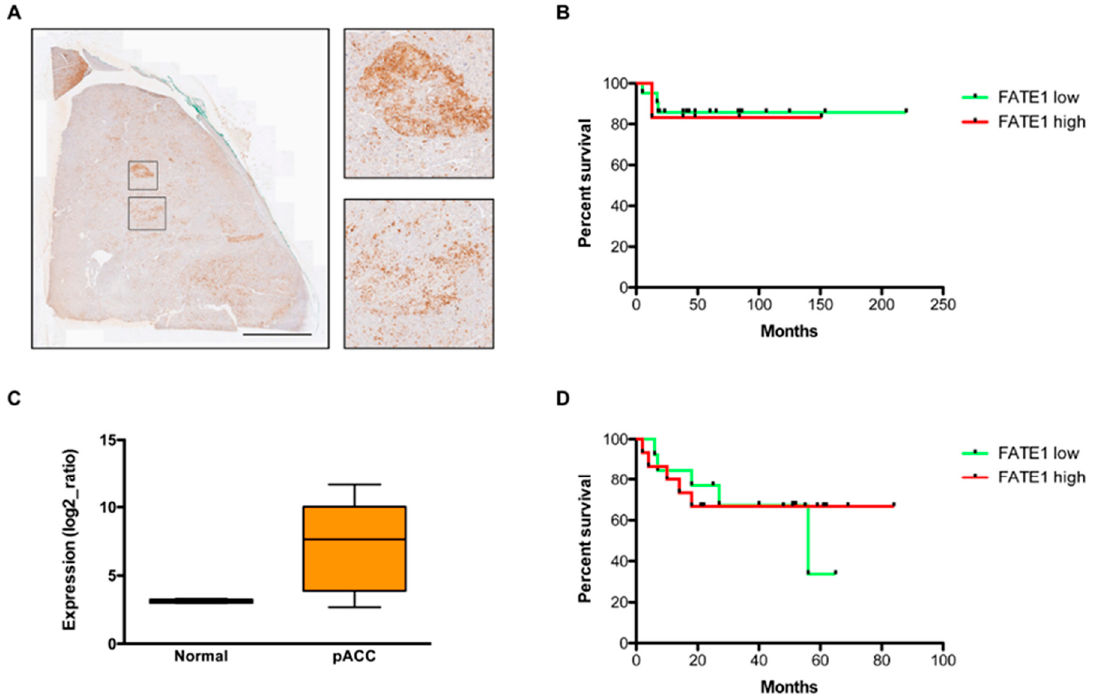
Figure 1. FATE1 expression and correlation with prognosis in pediatric ACC. ( A ) FATE1 IHC staining in a pediatric ACC. Two groups of FATE1-positive cells are shown at higher magnification. Scale bar, 5 mm. ( B ) Disease-free survival analysis in a cohort of children with ACC ( n = 27) according to their low (H-score ≤ 1; 21 patients) and high (H-score > 1; 6 patients) tumor FATE1 expression. Log-rank, p = 0.8660. ( C ) FATE1 mRNA expression in normal children adrenal ( n = 5) and in a cohort of pediatric ACC (pACC; n = 28). p = 0.0072, Mann-Whitney test. ( D ) Disease-free survival analysis of children with ACC according to their low ( < 2 × expression compared to normal adrenal; 13 patients) and high ( > 2 × expression compared to normal adrenal; 15 patients) tumor FATE1 mRNA expression. Log-rank, p = 0.8212.